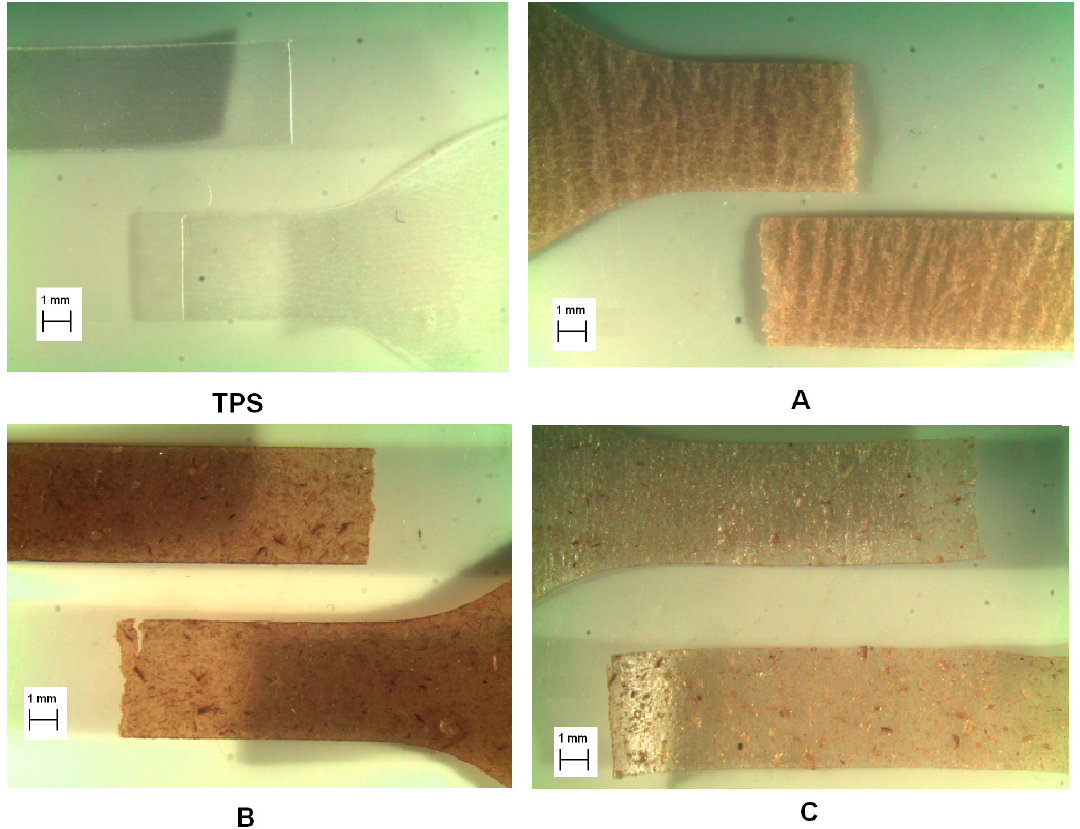
Figure 7. Tensile fractured samples of pure TPS and TPS–dry nopal fiber composites (type A, B and C, respectively). Table 2. Tensile tests results for pure TPS and its composites.